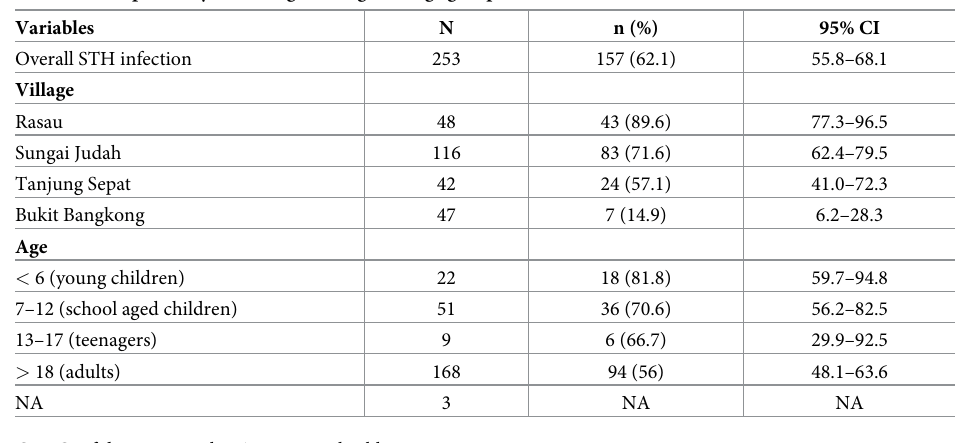
Table 4. STH positivity according to village and age